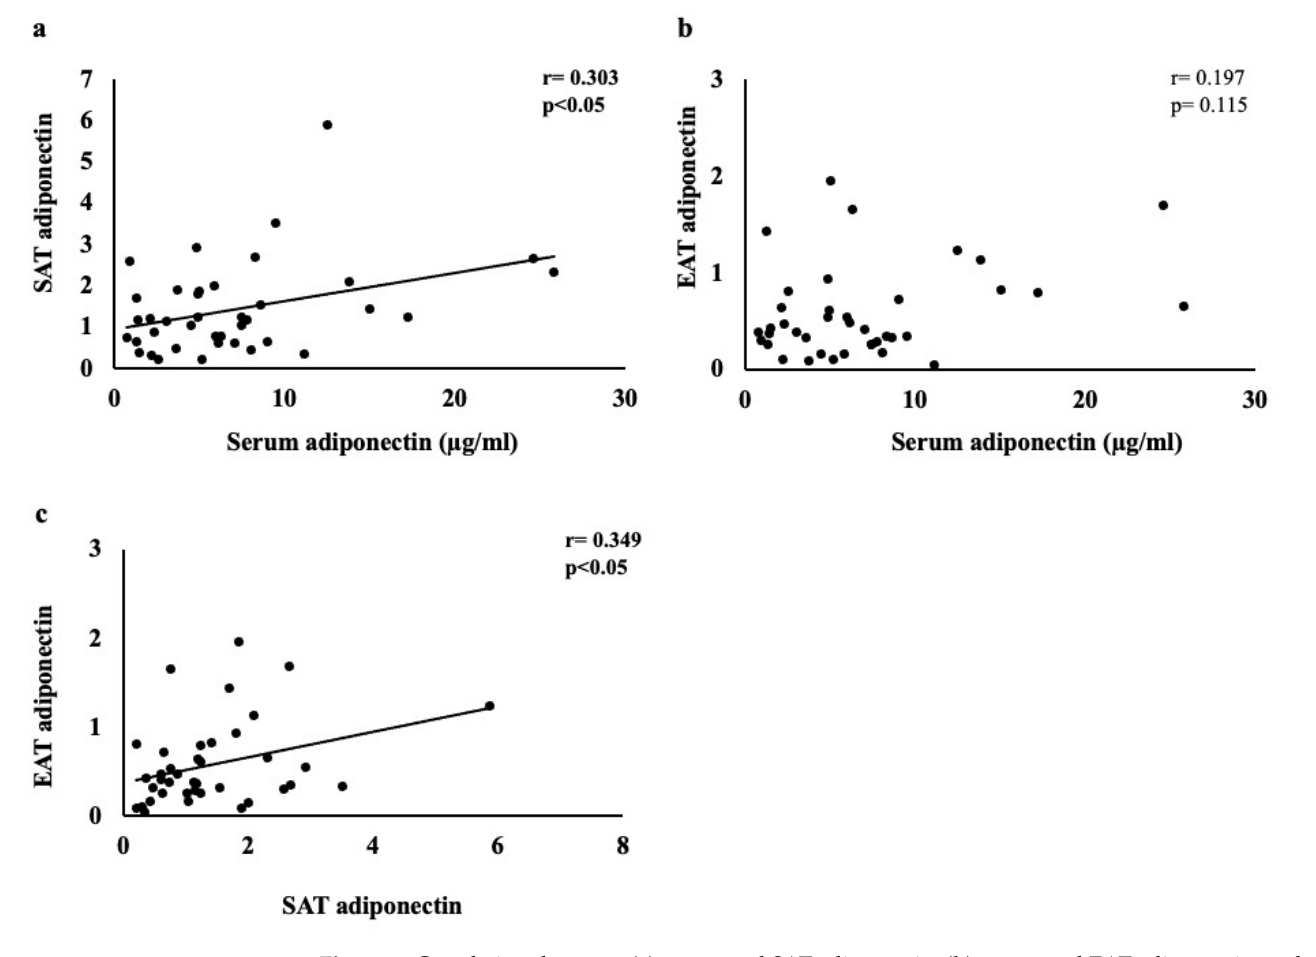
Figure 3. Correlations between ( a ) serum and SAT adiponectin, ( b ) serum and EAT adiponectin, and ( c ) SAT and EAT adiponectin. Table 3. Correlation between adiponectin and other parameters in serum, subcutaneous adipose tissue, and epicardial adipose